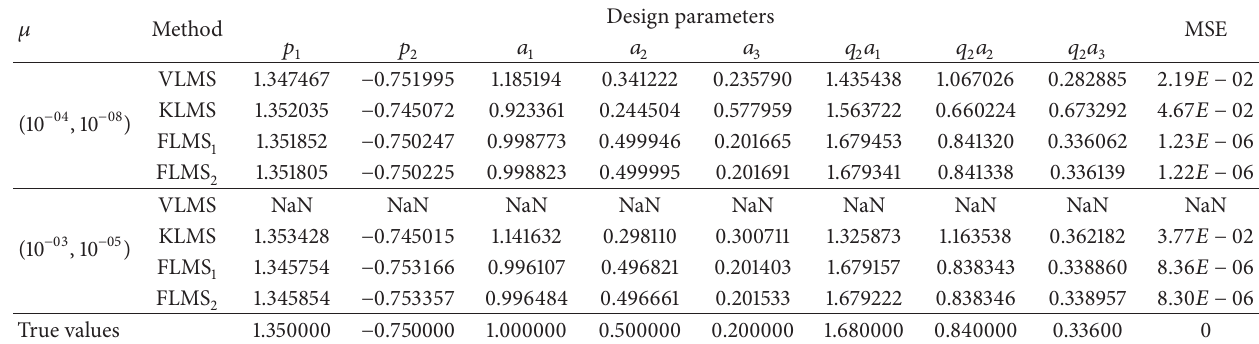
Table 2: Comparison of proposed results against true values of INCAR model for 20 dB SNR.